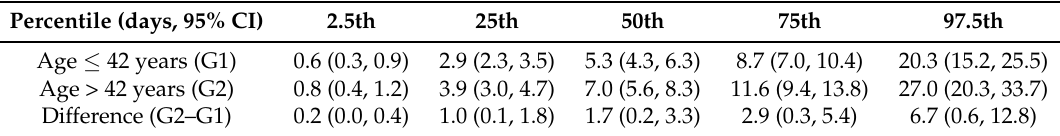
Table 2. Estimated differences of specific quantiles of the incubation period among both age groups (patients aged > 42 years – patients aged ≤ 42